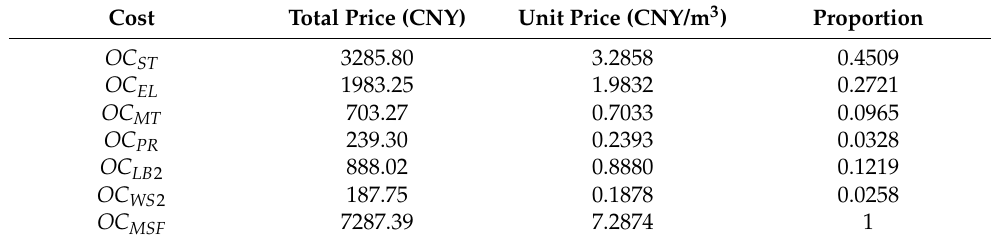
Table 18. BR-MSF system cost ratio table.